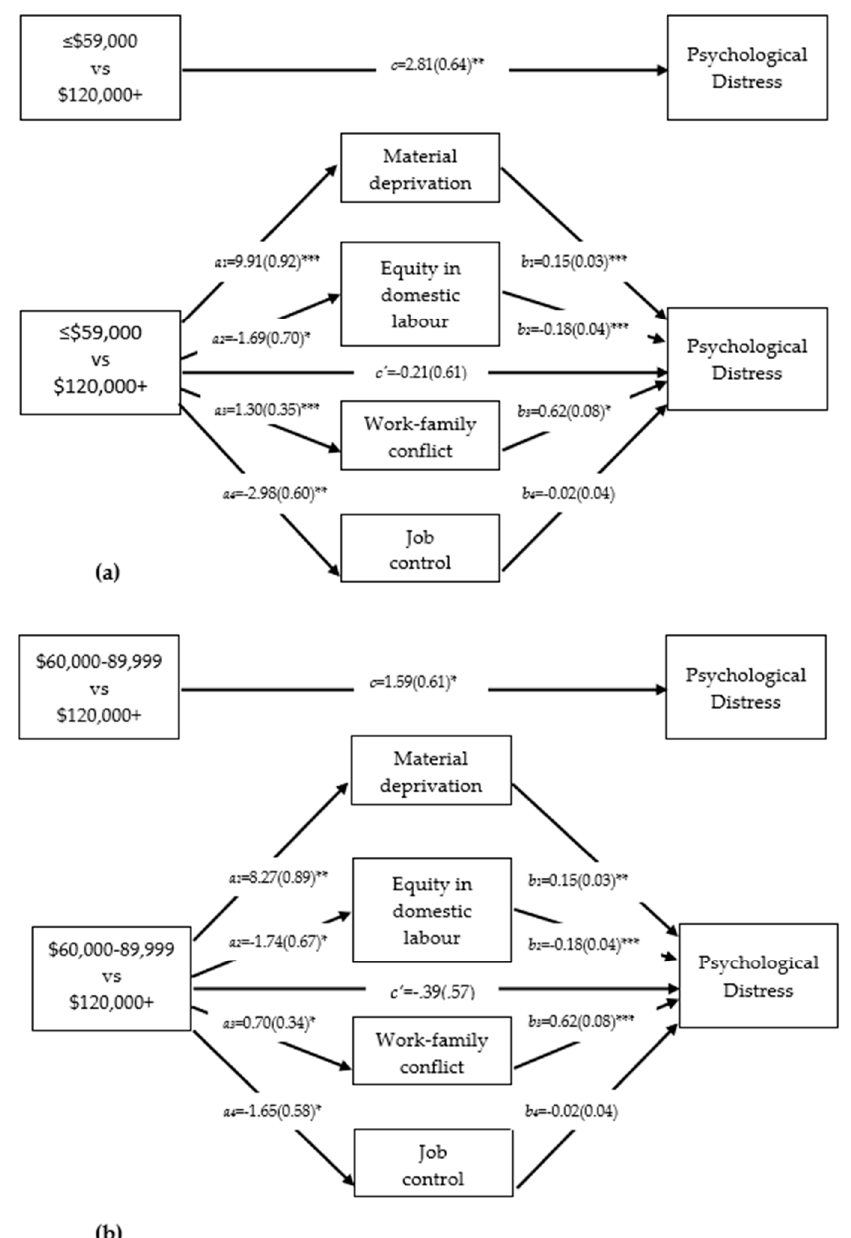
Figure 1. Results of multiple mediation analysis examining effects of household income on distress through material deprivation, equity, work–family conflict, and job control ( n = 512). 1 ( a ) Contrast between women in the ≤ CAD 59,000 income group and those in the CAD120,000+ category; ( b ) Contrast between women in the CAD 60,000– CAD89,900 income group and those in the CAD 120,000+ category. 1 Adjusted for mothers’ age and paid work hours; * p < 0.05, ** p < 0.01, *** p < 0.001. Table 4. Relative indirect effects and partially standardized indirect effects of income on psychological distress through material deprivation, equity in unpaid work, work–family conflict, and job control ( n = 512) 1 .